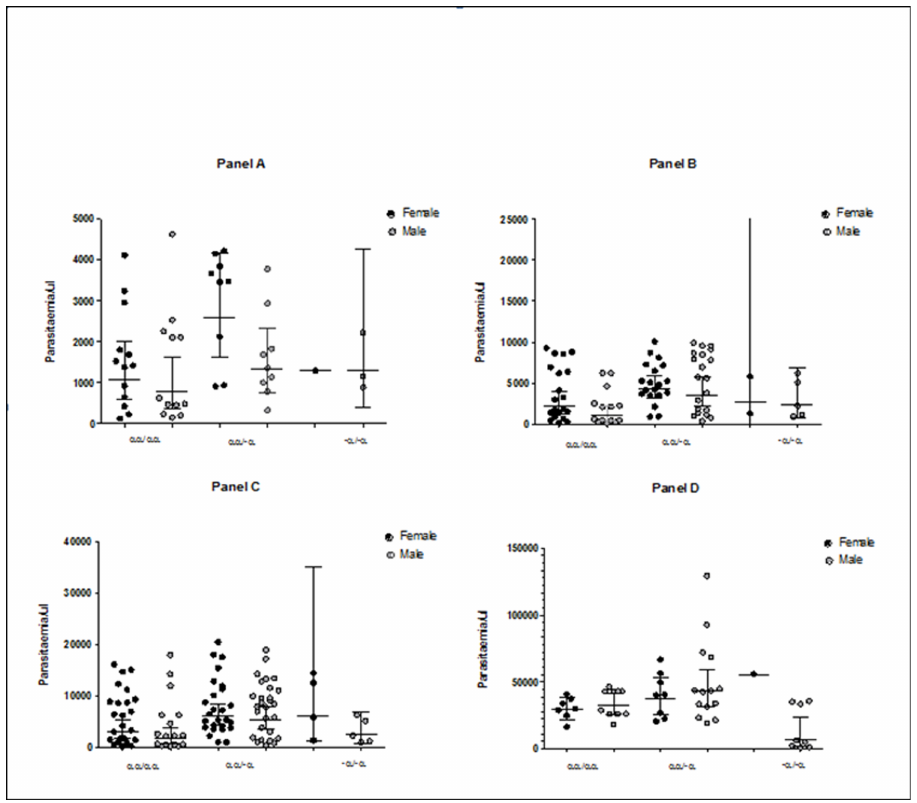
Fig 2. Dot plot showing geometric mean parasite densities within the 25%, 50%, 75% and > 75% quartile ranges for boys and girls of HbAS genotype. This data came from multiple sick visits with the 265 days follow-up period. Due to the high variability and with a wide range of parasitemia data, analysis was done at different distribution quartiles. At all the quartile ranges 25%, 50% and 75% (panels A, B and C respectively) the parasite geometric mean for females of HbAS/ αα / αα genotype was much higher than for males. As shown in panel C, the median parasite density within the third quartile was two times higher in females of HbAS/ αα / αα genotype (3,118, 95% CI: 1779–5465) than for males (1,676, 95% CI : I752-3733). This trend was maintained across the ordered α -thalassemia genotypes (Kurskal-Wallis; 0.0422). A second loss of α + -thal gene increased the parasite load even further. Each dot represents parasitemia from a sick visit from the